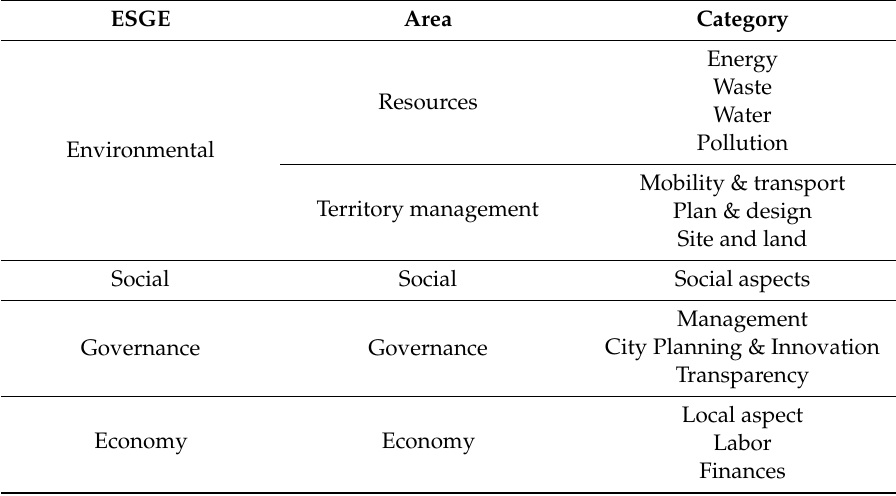
Table 2. Proposed category